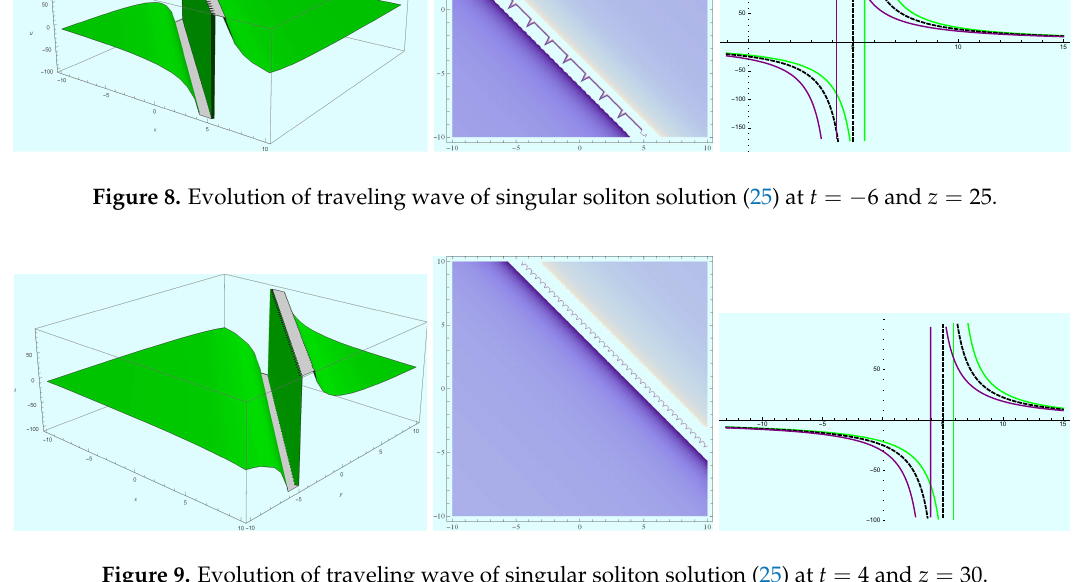
Figure 9. Evolution of traveling wave of singular soliton solution (25) at t = 4 and z =